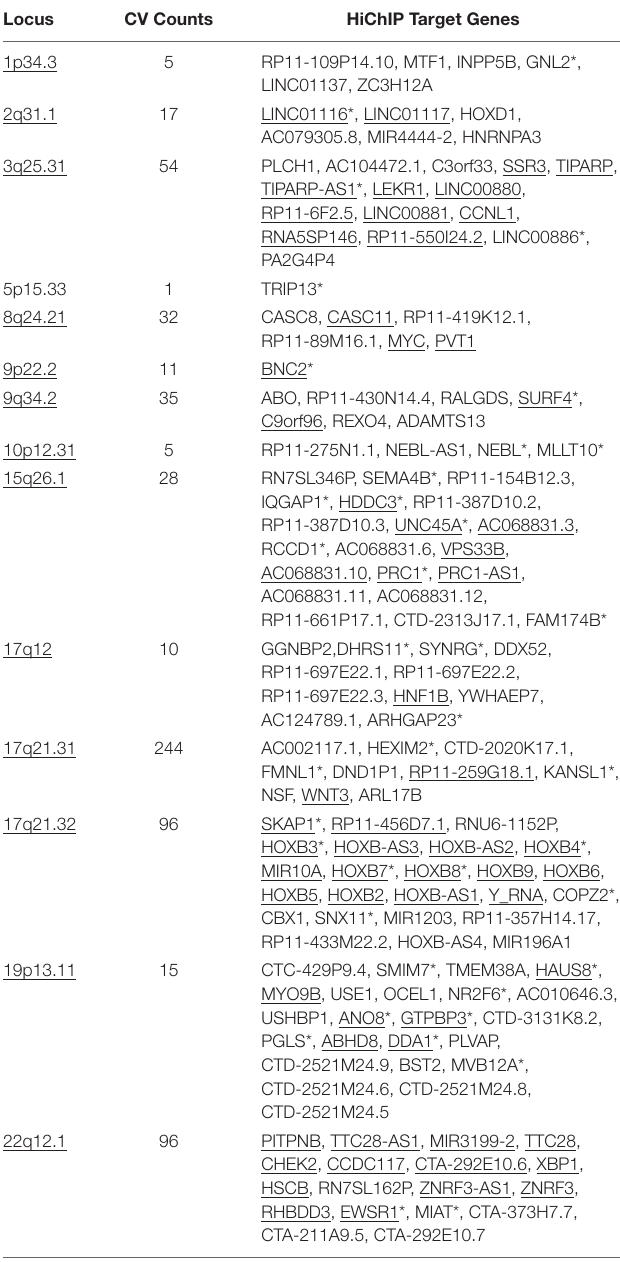
TABLE 1 | HiChIP target genes at EOC risk